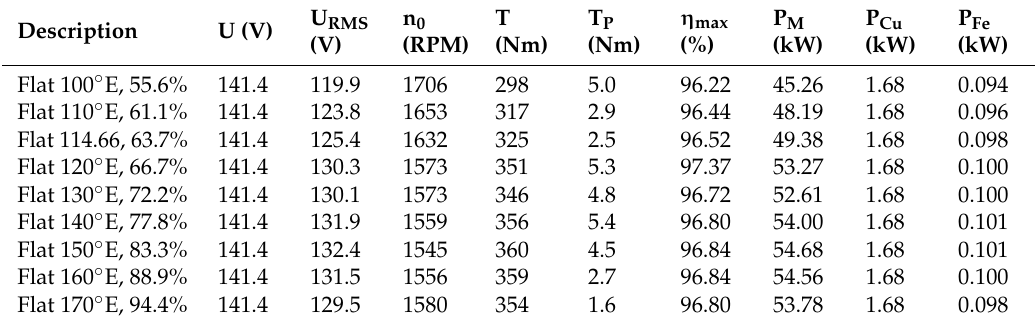
Flat 150 ◦ E, 83.3%